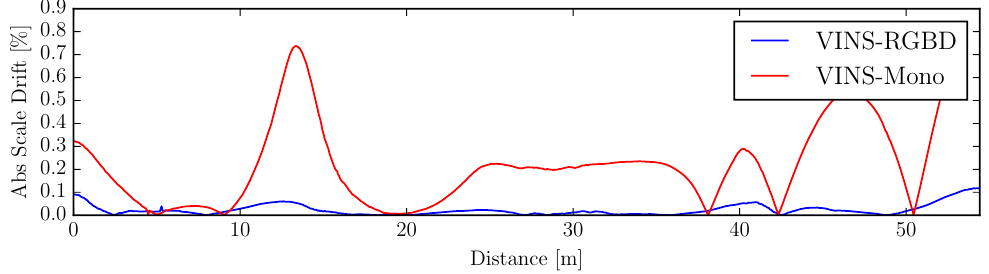
Figure 8. Absolute scale drift percentage of the deactivated loop closing